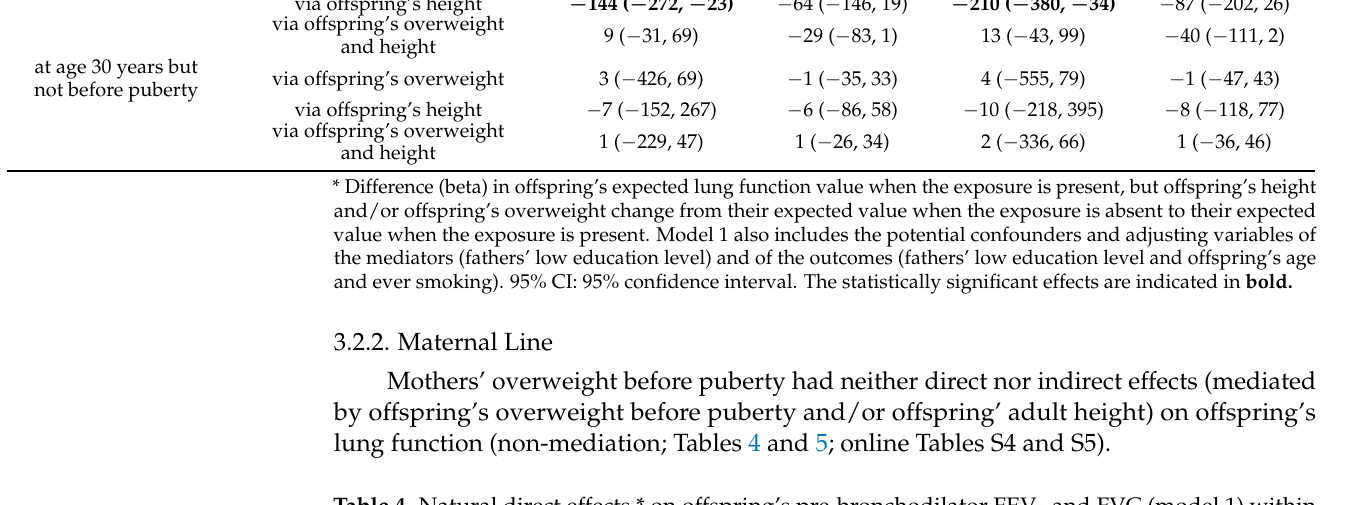
Table 4. Natural direct effects * on offspring’s pre-bronchodilator FEV 1 and FVC (model 1) within the maternal